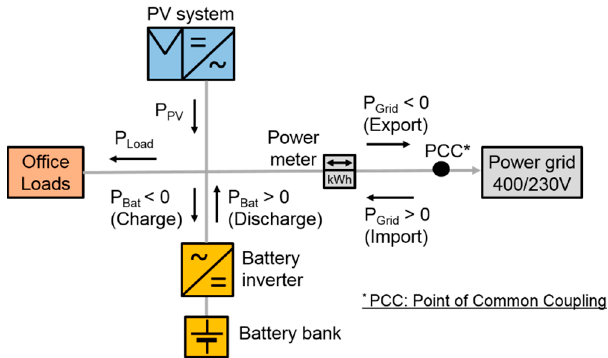
Figure 4. Grid-connected PV hybrid system components and topology.